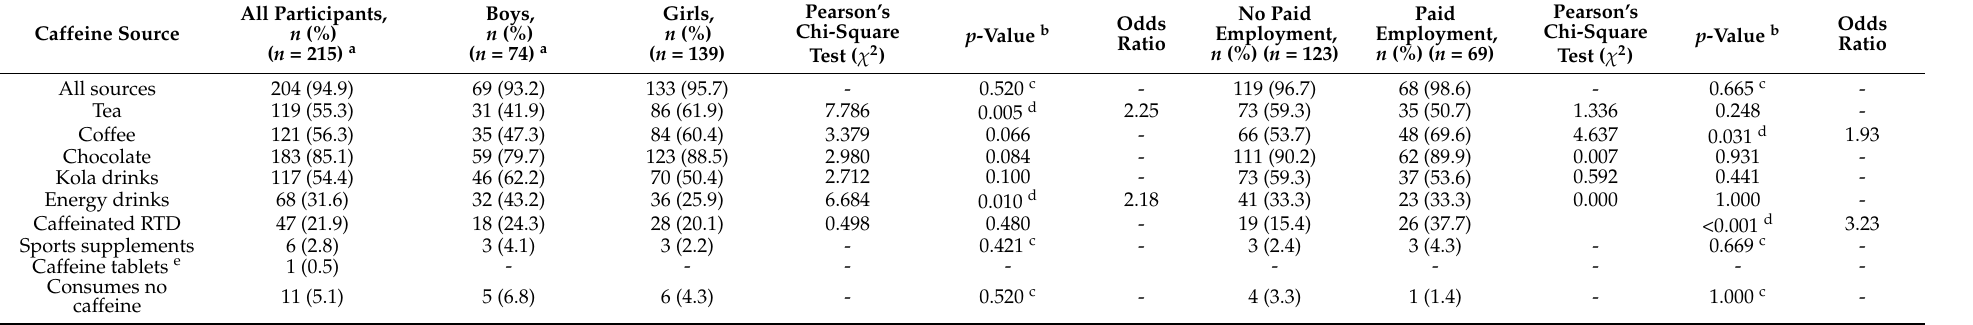
Table 2. Number and proportion of caffeinated products consumed overall and by gender and employment status.